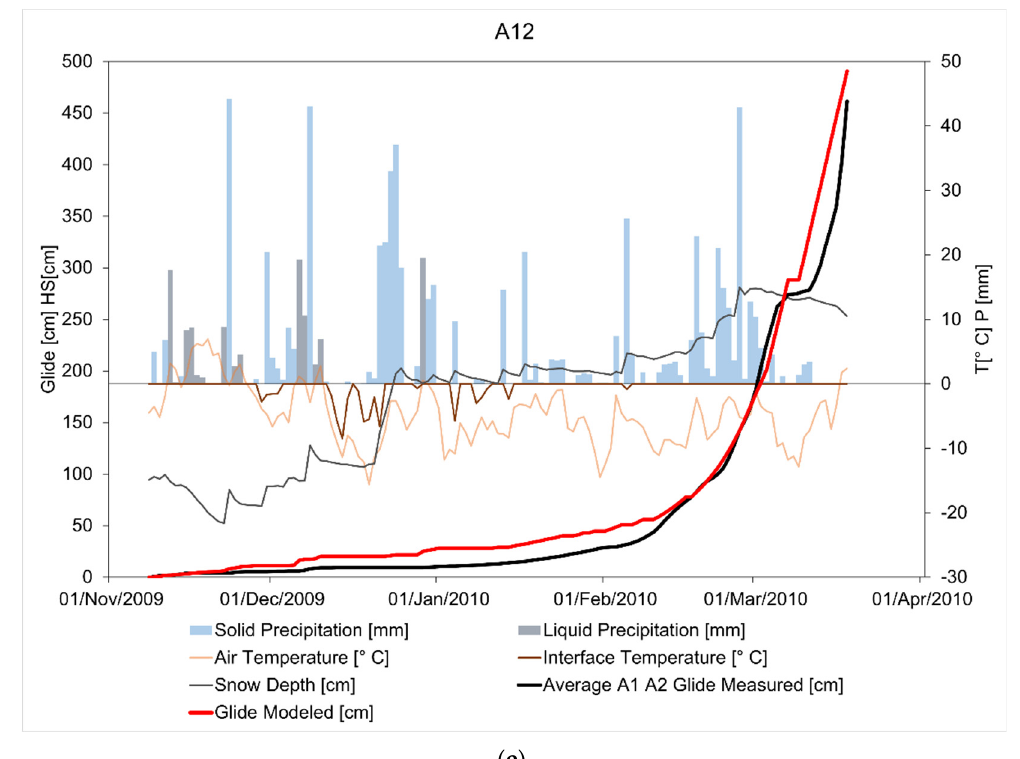
Figure 3. Cumulative glide measured and modeled, with information regarding solid and liquid precipitation, temperature of air, interface temperature (the snow temperature at the snow and soil interface), and snowpack depth. ( a ) A1. ( b ) A2. ( c ) B1. ( d ) B2. ( e ) A12, virtual glide shoe.